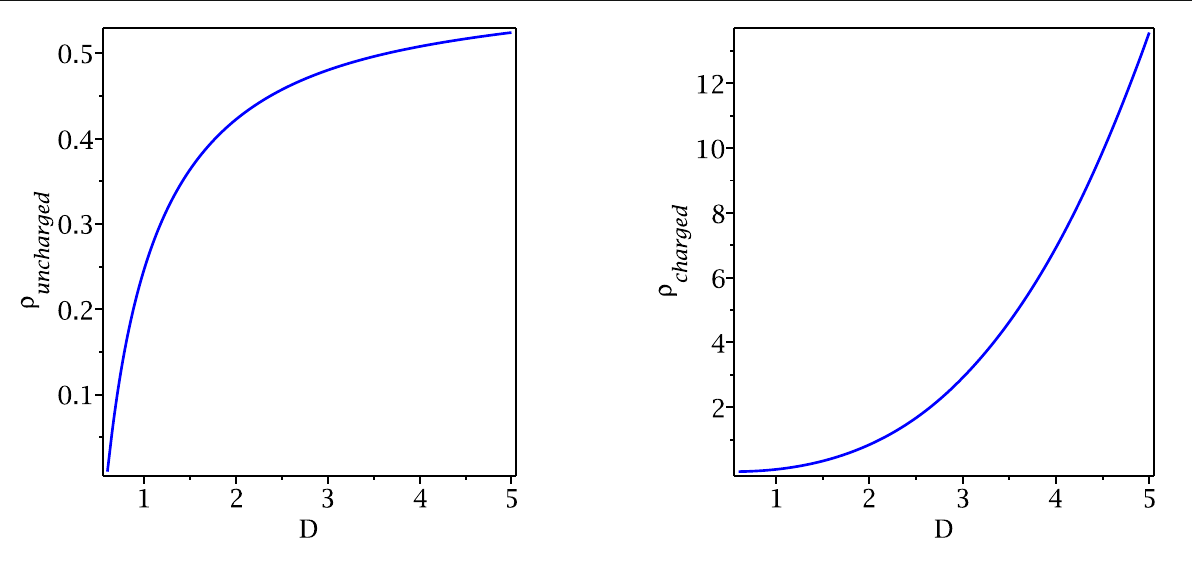
Fig. 12 The line energy density (cid:20) charged vs radius D . We have chosen m 0 = − 80, L (ε) = 1 . 1, H (ε) = 1 . 1, σ 0 = 4, C 0 = 1, (cid:8)(ε) = − 1, m = 1, q = 1, and l = 1